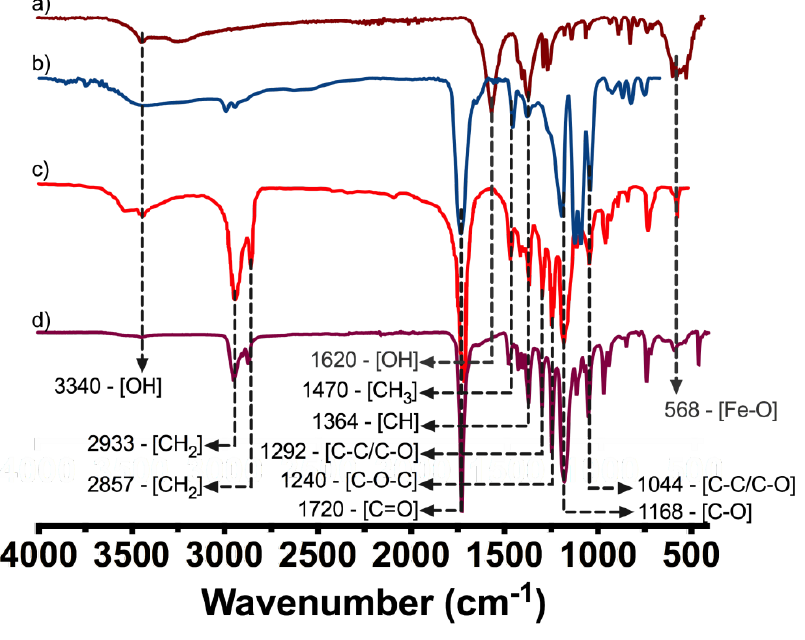
Figure 8. Fourier transform infrared spectroscopy (FTIR) spectrum from ( a ) IONPs, ( b ) PLA, ( c ) PLC and ( d ) BM-2 marker clip prototype (PLC/PLA/IONPs: 4.75/0.25/36.86·× 10 −3 ).